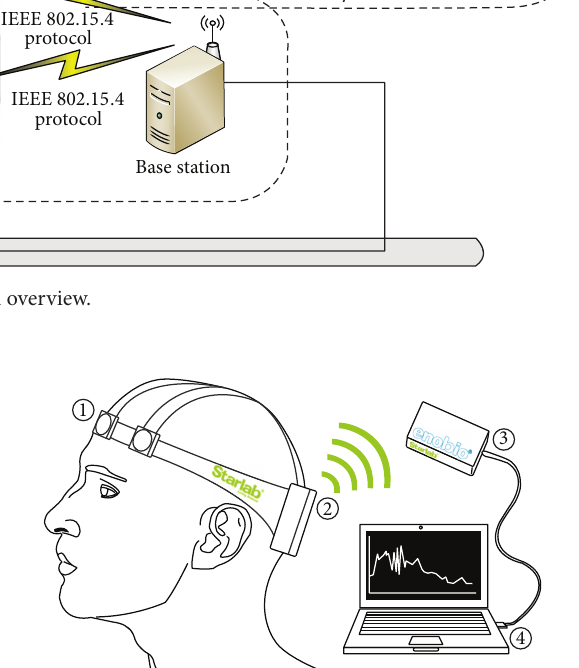
Figure 3: System 2—EEG analyzer. (1) Electrodes. (2)